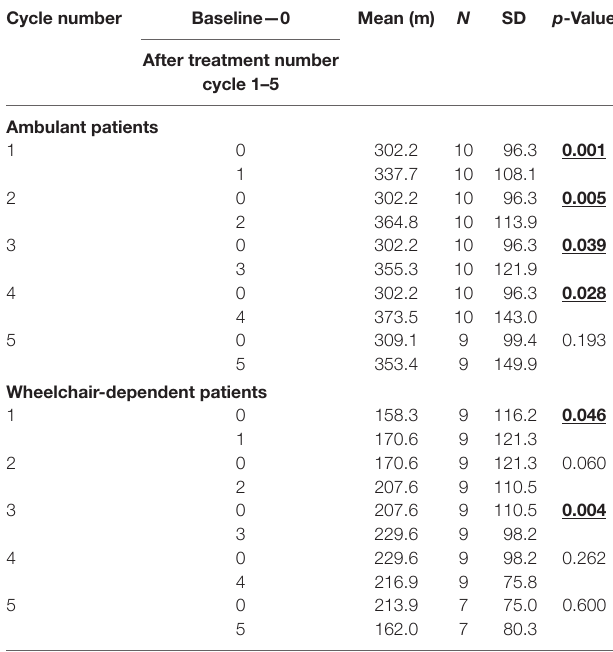
TablE 3 | Effect of granulocyte colony-stimulating treatment on 6-min walk test between baseline and each other cycle in ambulant and non-ambulant patients with Duchenne muscular dystrophy.